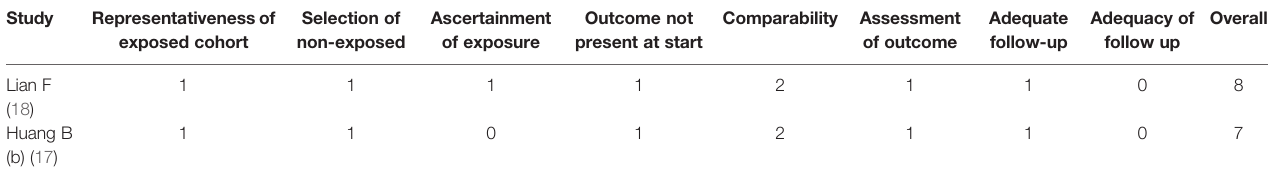
TABLE 3 | Risk of bias according to Newcastle-Ottawa Scale (NOS) in included retrospective